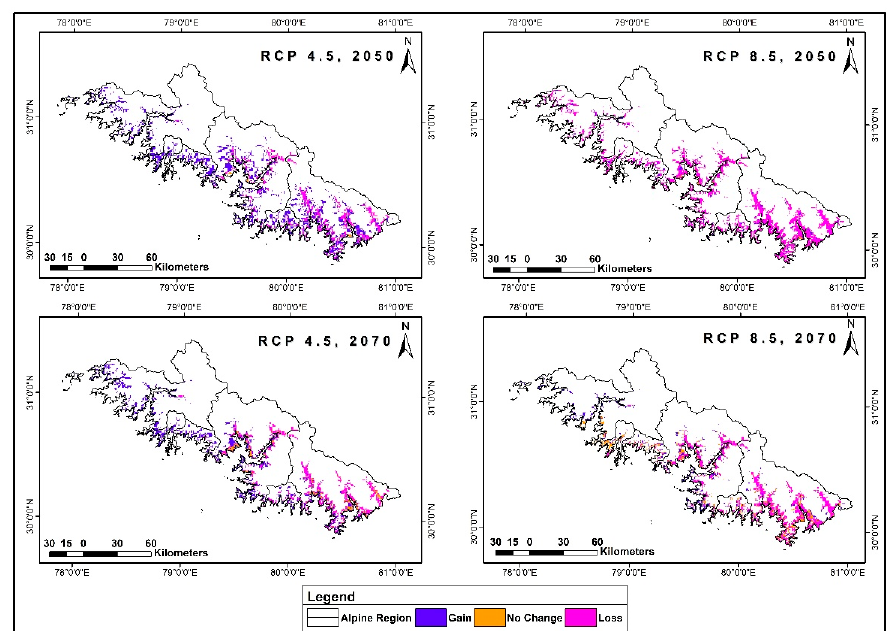
Figure 7. Predicted range contraction for C. elegans.